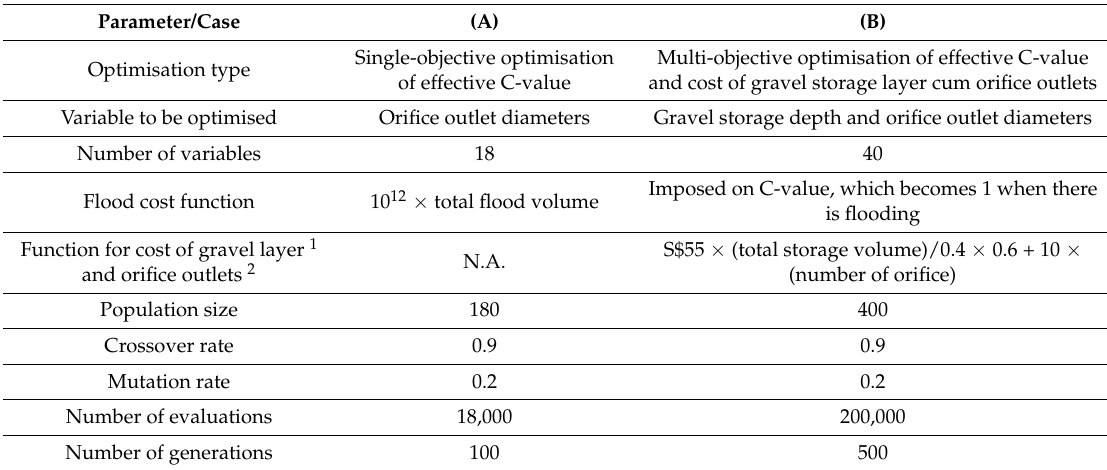
Table A2. Optimisation parameters for the optimisation of (A) orifice outlet diameter and (B) gravel storage depth and orifice outlet